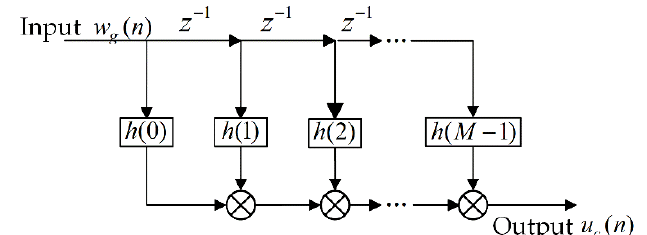
Figure 12. Structure of feedforward controller.